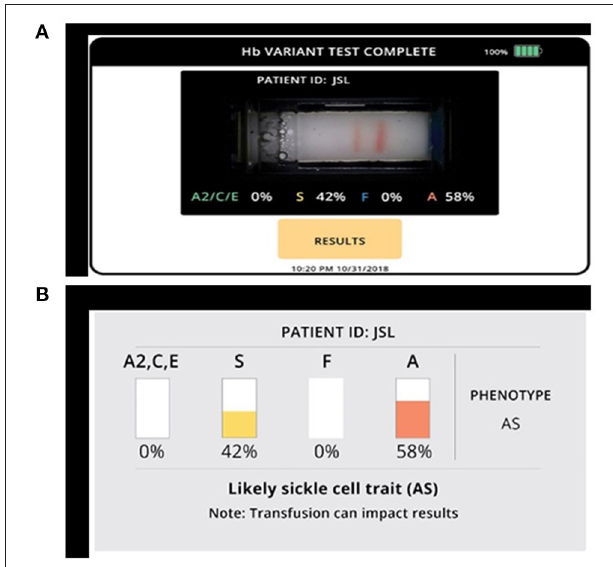
FIGURE 2 | Gazelle shows qualitative and quantitative measurements of various hemoglobin variants. (A) Microchip electrophoretic image showing separation of HbA and HbS with per cent quantification. (B) Diagrammatic representation of various hemoglobin variants.